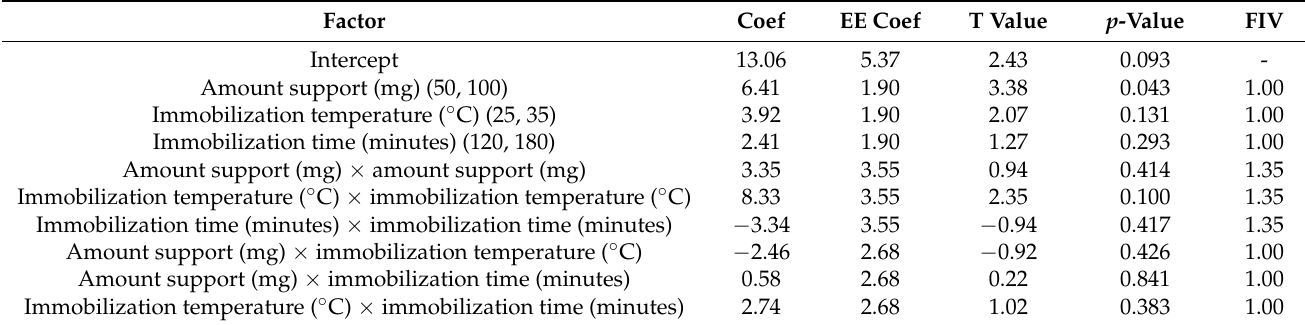
Table 2. Response surface regression coefficients: Enzymatic activity vs. amount support, immobi- lization temperature, and immobilization time (coded coefficients).